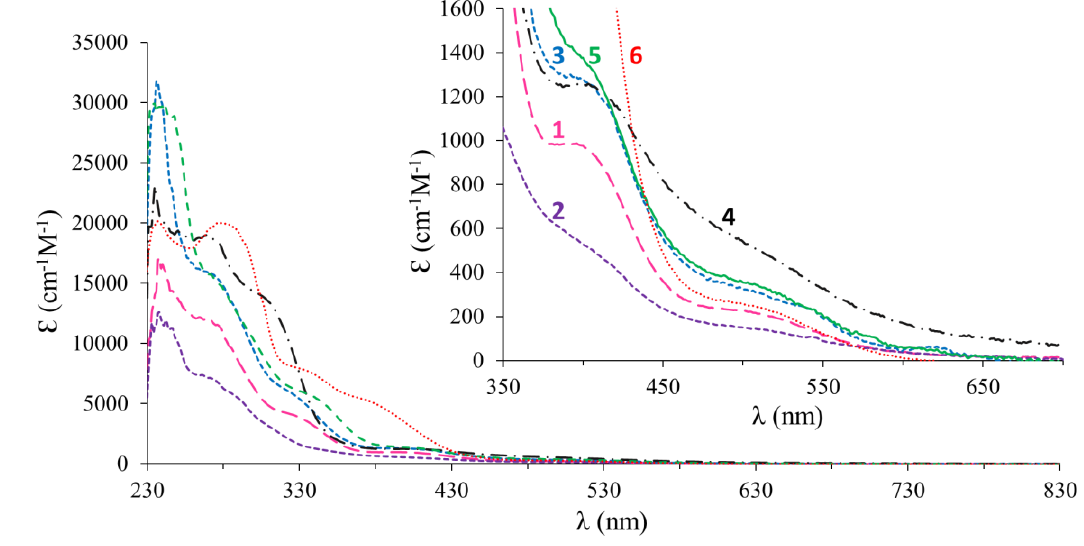
Figure 2. Electronic spectra of complexes 1 – 6 in DCM solution.